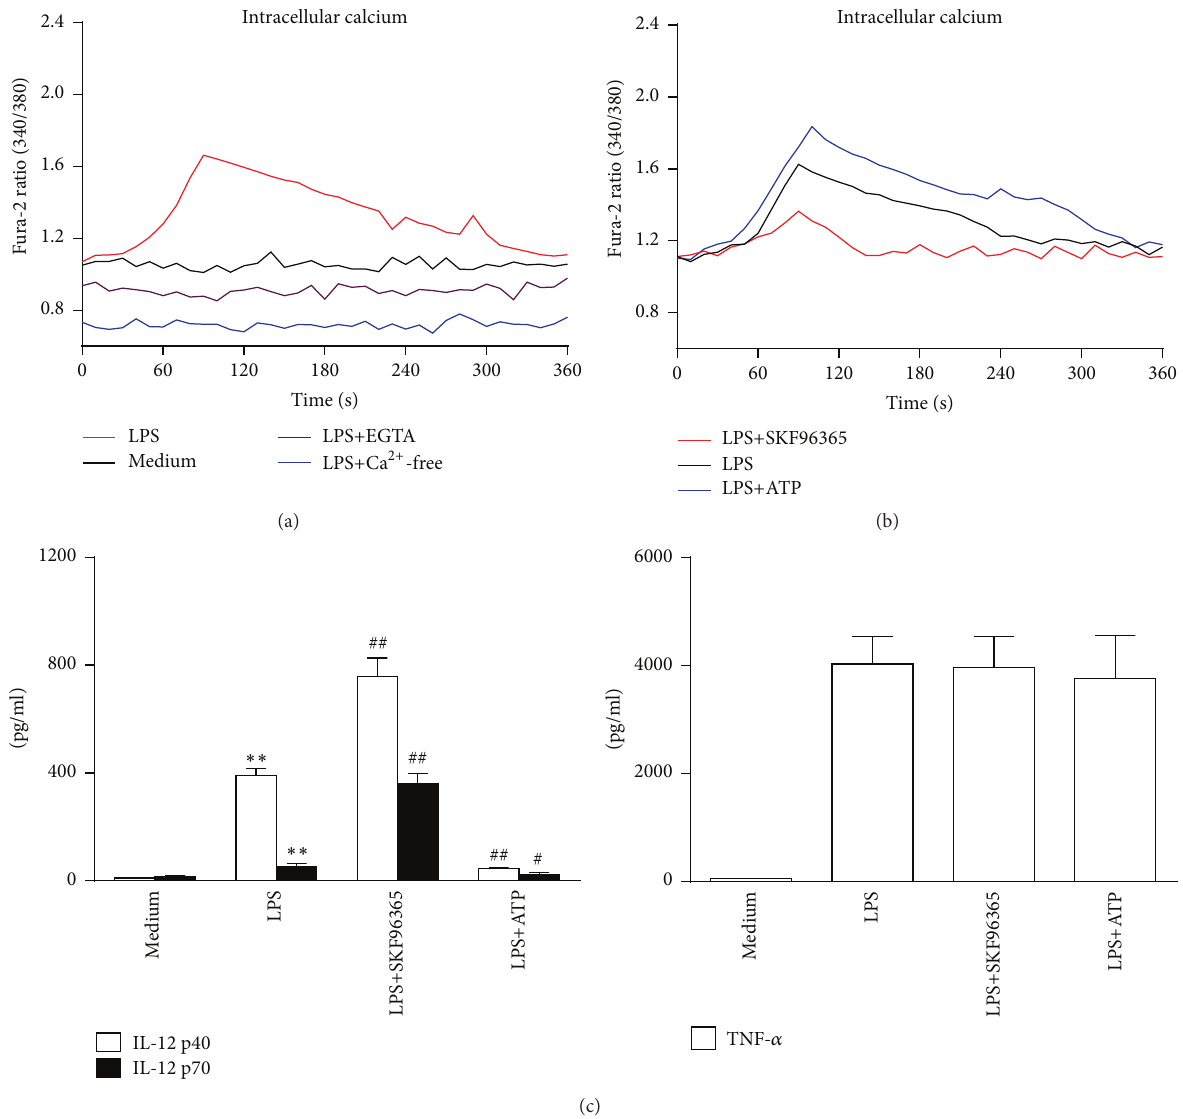
Figure 3: LPS induced extracellular calcium influx and modulation of calcium influx affects IL-12 production in murine peritoneal macrophages. (a, b) Macrophages were incubated with LPS (1 𝜇 g/mL) or LPS plus calcium-free DMEM, 5 mM EGTA, 5 𝜇 M SKF96365, or 100 𝜇 M ATP for 6min. The fluorescence ratio (340nm/380 nm) of Fura-2AM was captured by using the plate reader assay every 10s ( 𝑛 = 4 ). (c) Macrophages were treated with 5 𝜇 M SKF96365 (SKF) or 100 𝜇 M ATP for 1h and then stimulated with 100ng/mL LPS. Supernatants were collected 24h later and IL-12 p40 and IL-12 p70 levels were detected by ELISA. ∗∗ 𝑃 < 0.01 versus medium; # 𝑃 < 0.05 versus LPS; ## 𝑃 < 0.01 versus LPS ( 𝑛 = 3